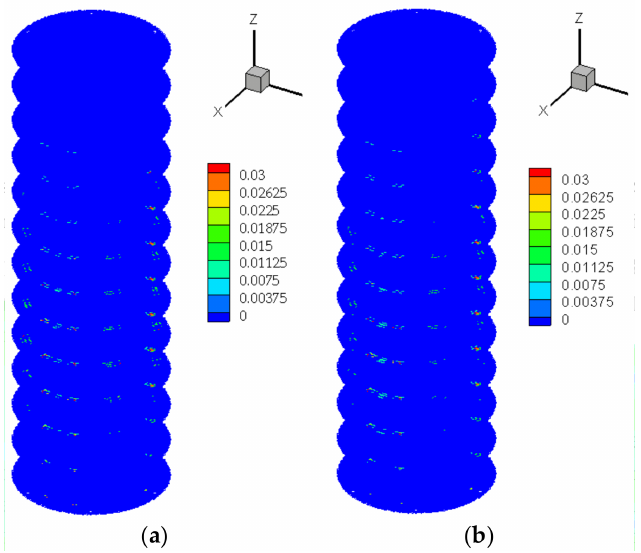
Figure 19. Interlayer shear damage comparison for ( a ) coupled case and ( b ) uncoupled case at 0.3461 × 10 − 3